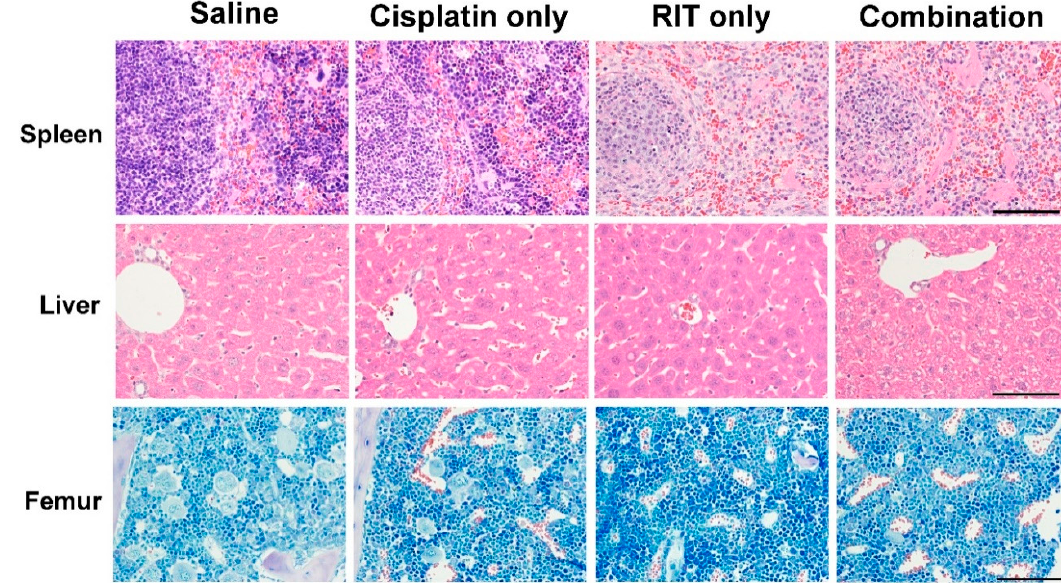
Figure 4. Day 7 organ specimen histopathology (400× magnification, scale bar: 100 µm).